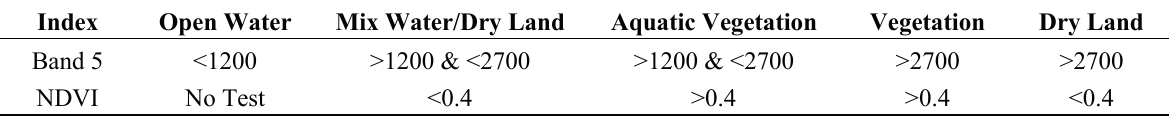
Table 1. Threshold value used for qualification of ground type is applied to monitor a flood event on the flood plain. Units are reflectance scaled by 10,000 as delivered in the MOD09GHK product (validation of this method is given in Section 3.2.3).